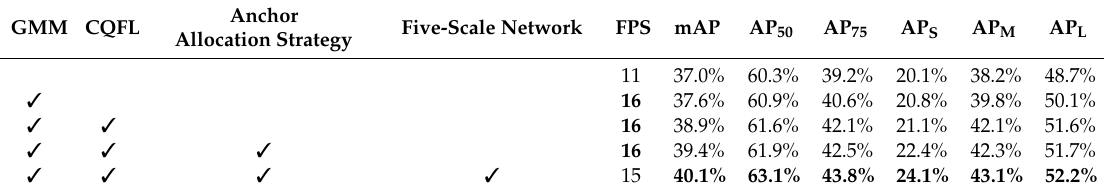
Table 5. The improvement of the baseline by tricks proposed in this